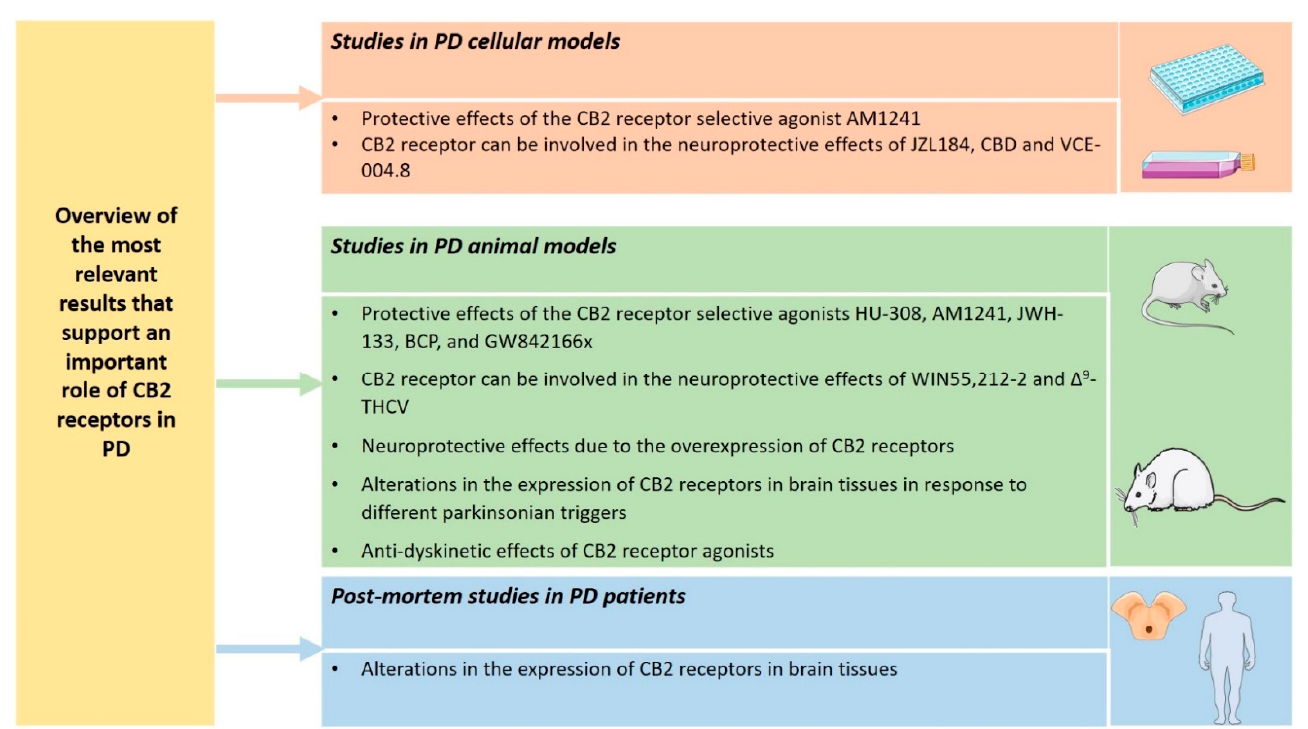
Figure 2. Overview of the most relevant results that support an important role of CB2 receptors in PD. The figure was partly generated using Servier Medical Art (http://smart.servier.com/, accessed on 1 October 2022), provided by Servier, licensed under a Creative Commons Attribution 3.0 Unported License (https://creativecommons.org/licenses/by/3.0/ (accessed on 21 October